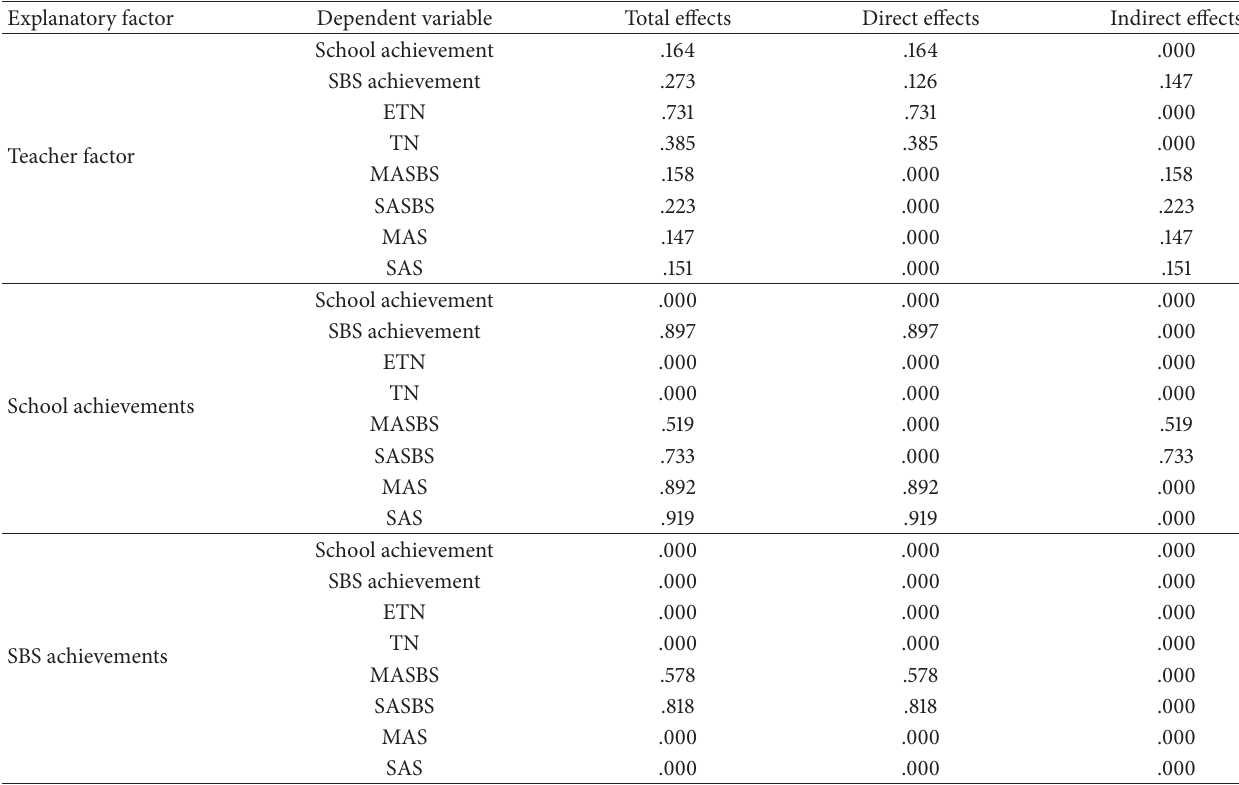
Table 5: Direct, indirect, and total effects between the variables in the